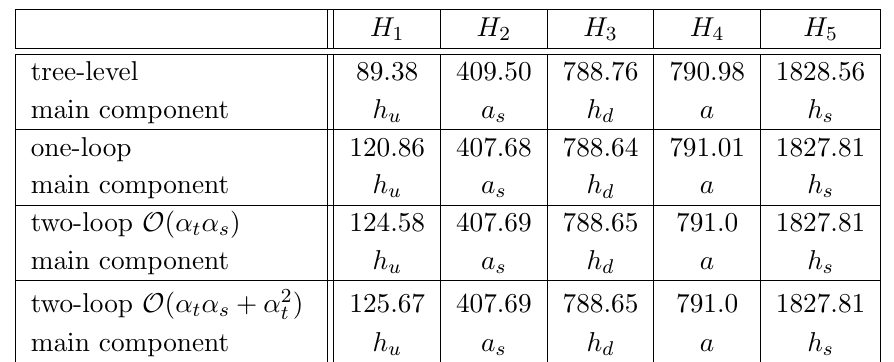
Table 4 . P2DR: mass values in GeV and main components of the neutral Higgs bosons at tree-level, one-loop, two-loop O ( (cid:11) t (cid:11) s ) and at two-loop O ( (cid:11) t (cid:11) s + (cid:11) 2 in the top/stop sector.